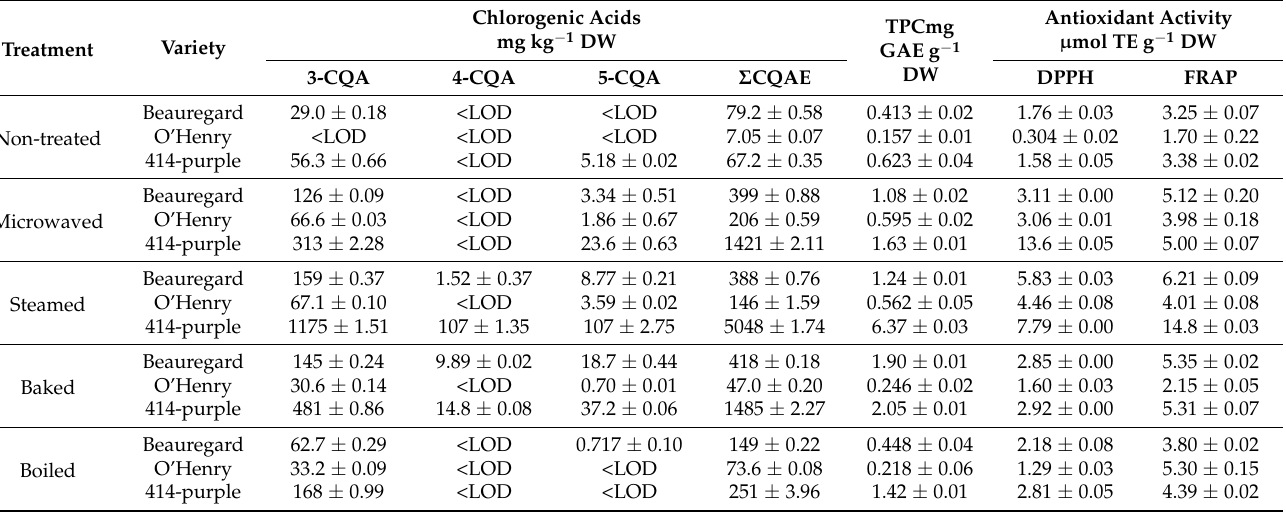
Table 1. Individual chlorogenic acids, total polyphenol content, and antioxidant activity in raw and heat-treated sweet